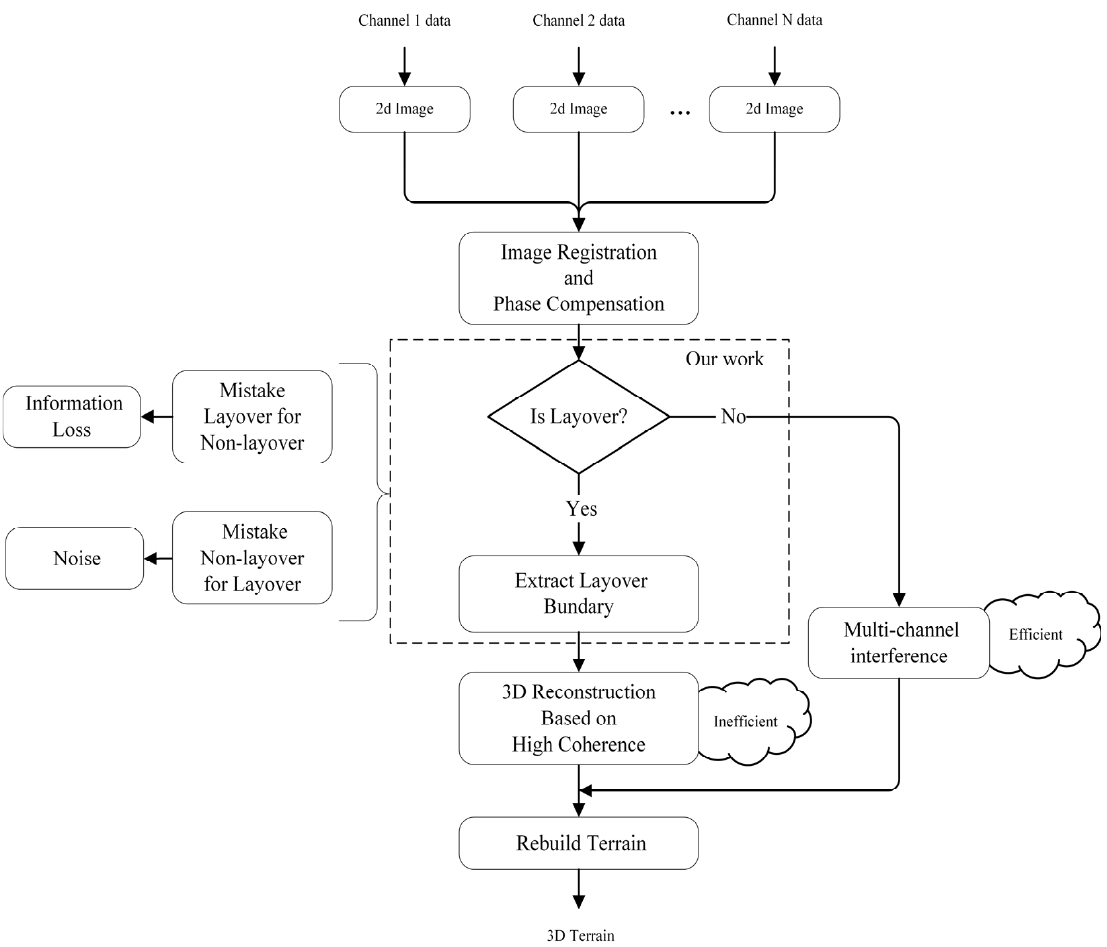
Figure 1. Array SAR 3D reconstruction flow chart introducing the location of our specific work in the overall process and the importance of this job.